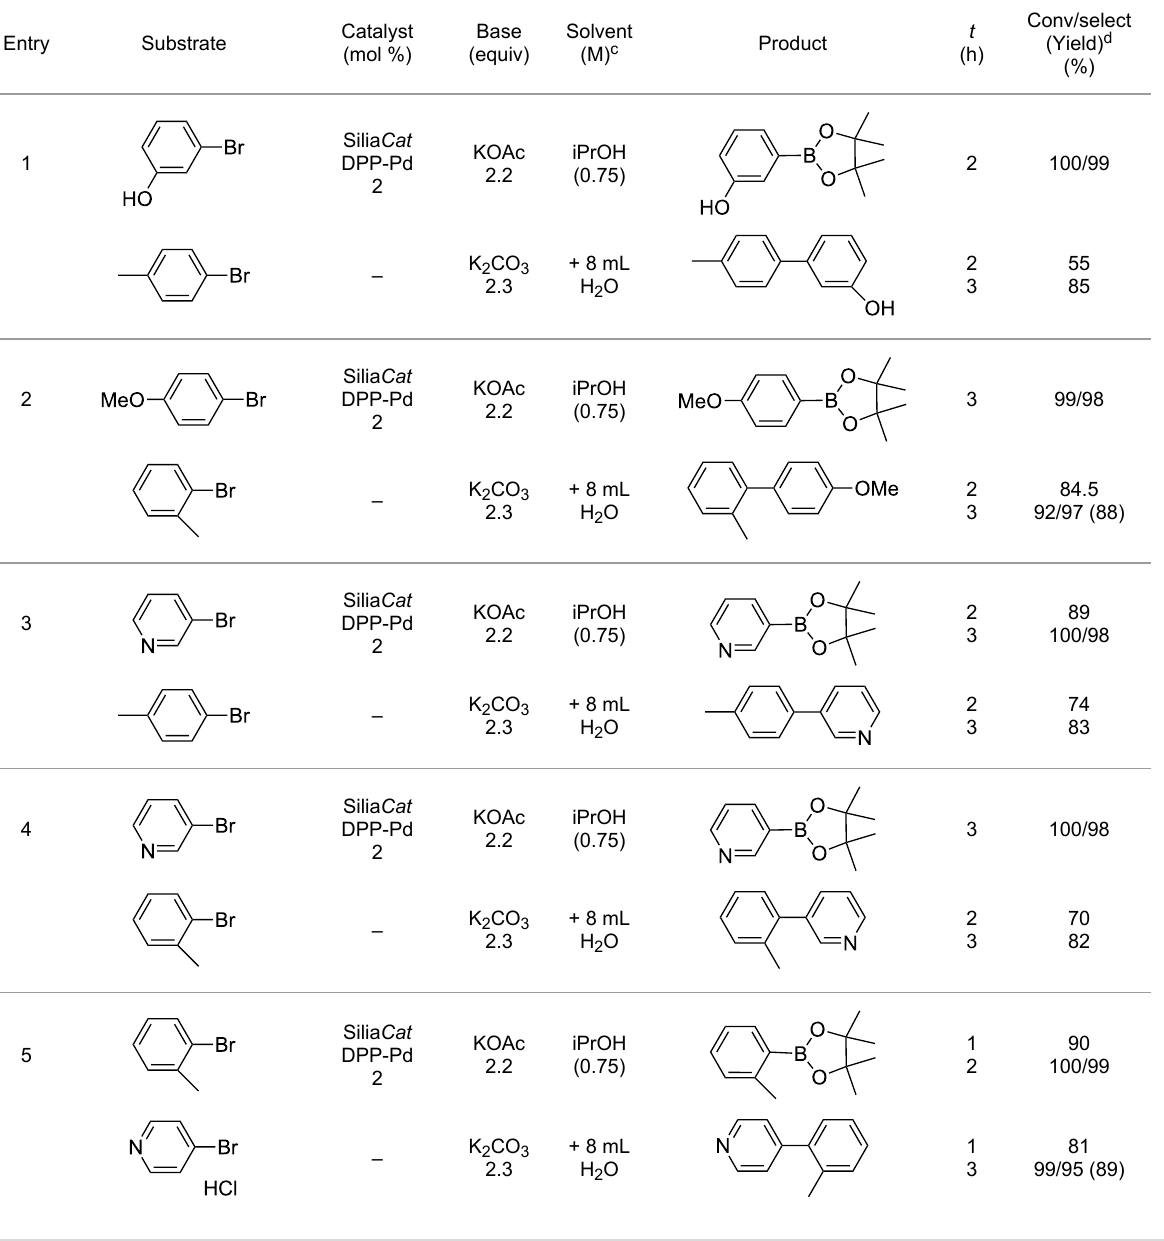
Table 1: One-Pot Silia Cat DPP-Pd-catalysed borylation a and Suzuki–Miyaura coupling b reactions.